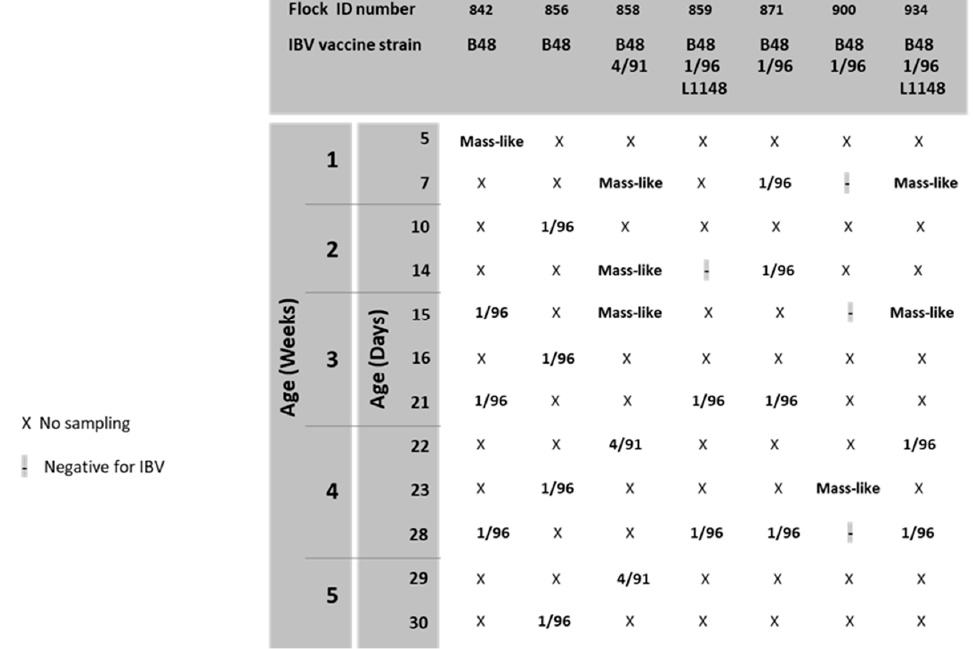
Figure 3. Results of IBV